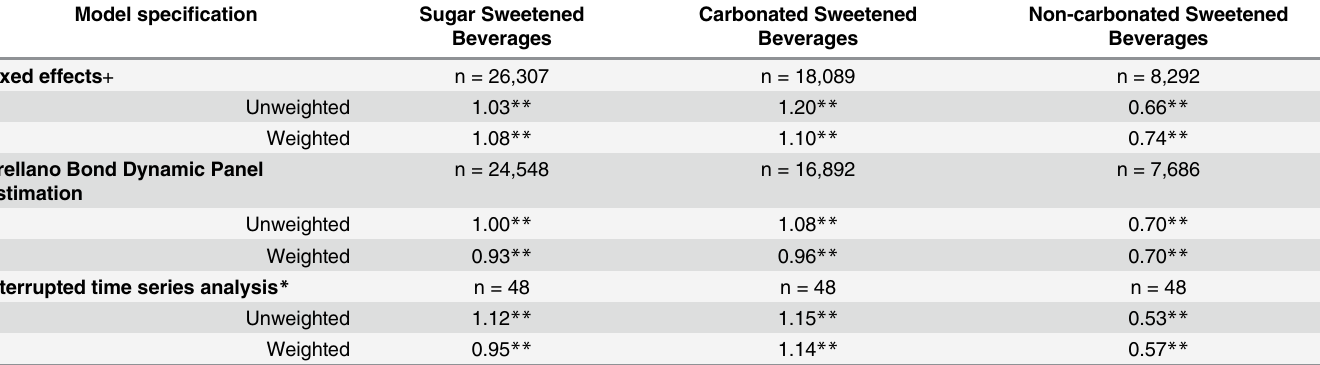
Table 4. Different model specifications estimating the change in prices after the excise SSB tax started by beverage type (unweighted and